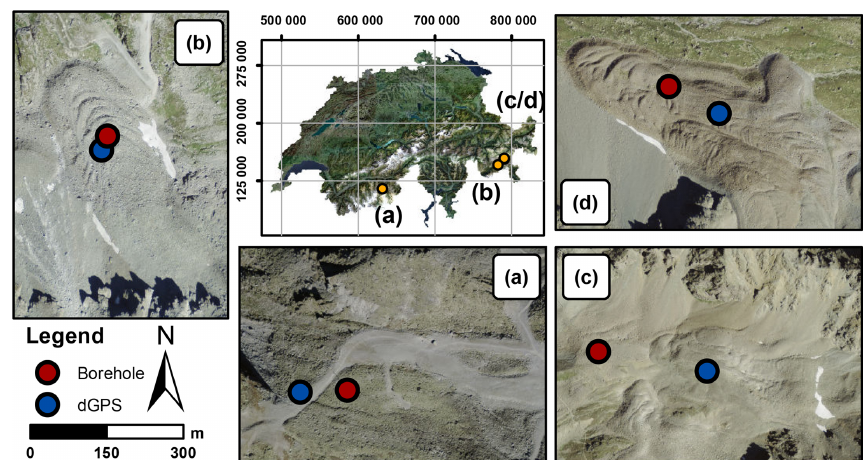
Figure 1. Overview of the four case study sites. Overview site map (middle) and aerial view of the four studied rock glaciers (a–d) with locations of boreholes (red dots) and DGPS (blue dots) according to PERMOS (2016a): (a) Ritigraben, (b) Murtèl, (c) Schafberg and (d)